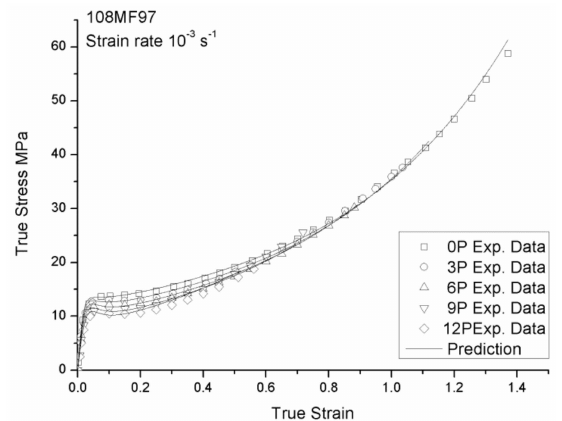
Figure 8. Comparison between the experimental and the predicted tensile behavior of the non-recycled and recycled 108MF97 under the strain rate of 0.001s − 1 .